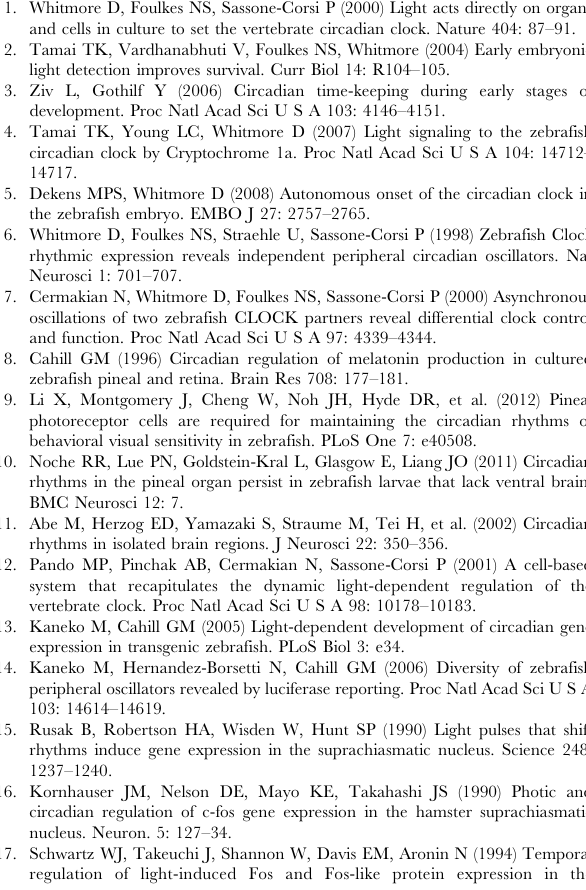
Table S1 A summary of all in situ hybridization results. This table summarizes all of the in situ hybridization data collected in this study for per3 rhythmicity, cry1a and per2 light induction, and c-fos changes in response to light for all of the brain regions examined. Strong positive staining is subjectively indicated indicated by a ‘‘ 2